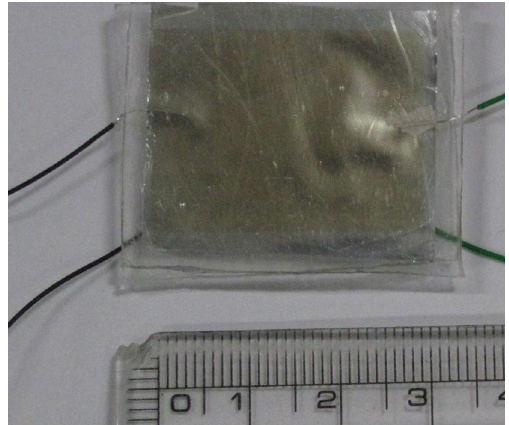
Figure 5. Fabricated sensor.